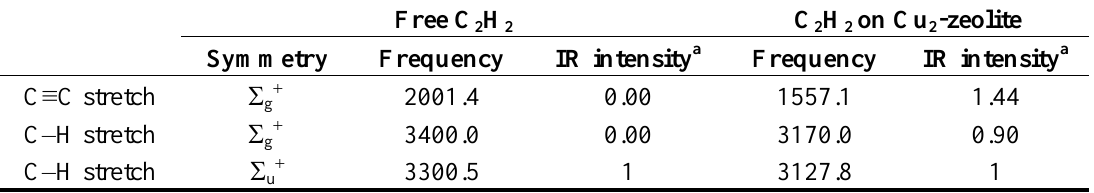
Table 6. Calculated vibrational frequencies (cm -1 ) of CC and CH stretching modes of C before and after the binding into the small dicopper zeolite model.